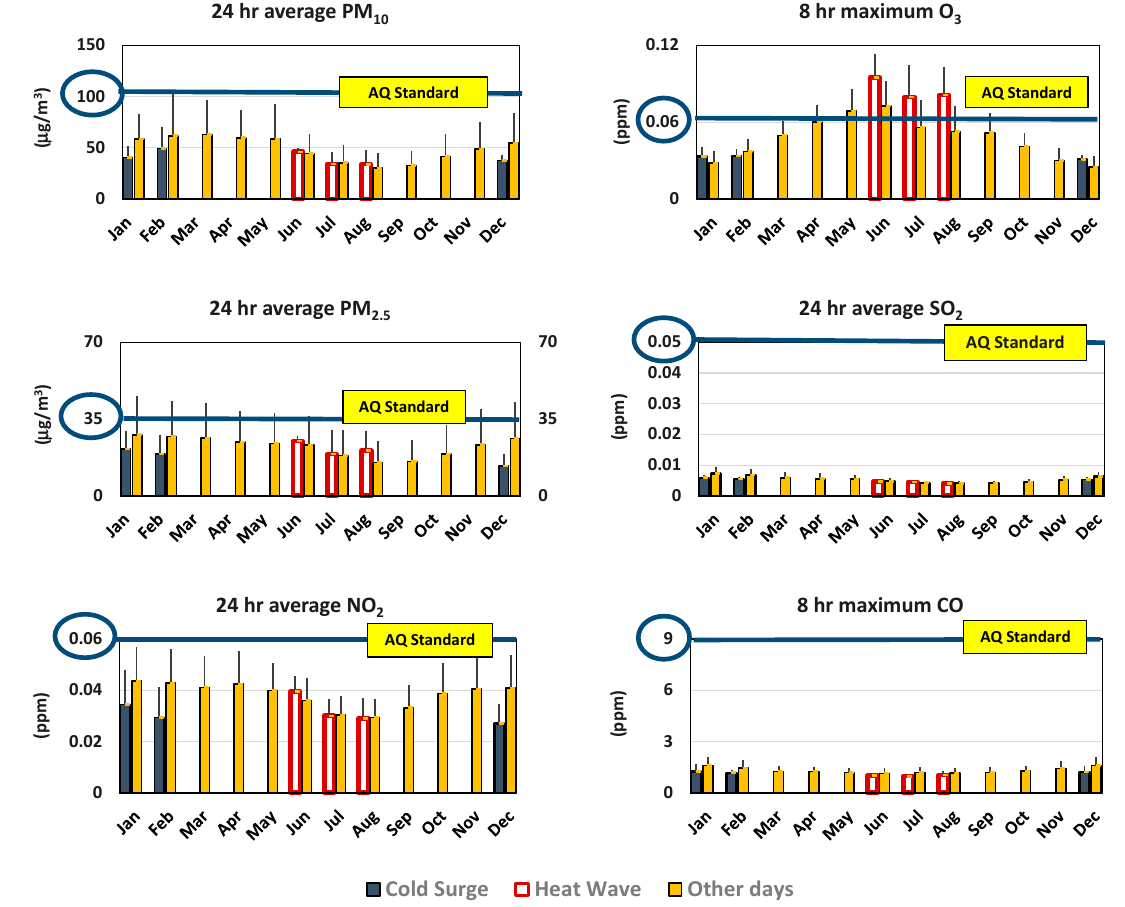
Figure 3. Monthly average (box) and one standard deviation (spike on top of the box) of pollutant concentrations in Seoul, Korea between 2008 and 2018 for PM 10 , PM 2.5 , NO 2 , O 3 , SO 2 , and CO.